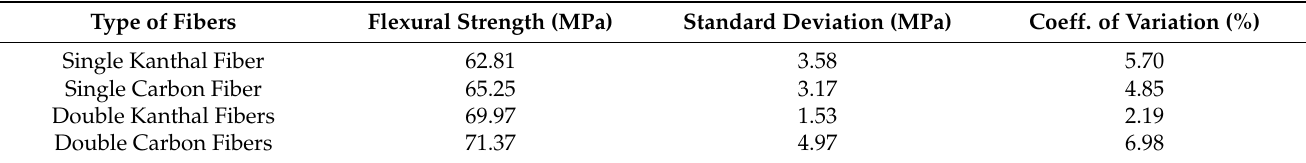
Table 2. Statistical analysis of flexural strength values for different type and number of